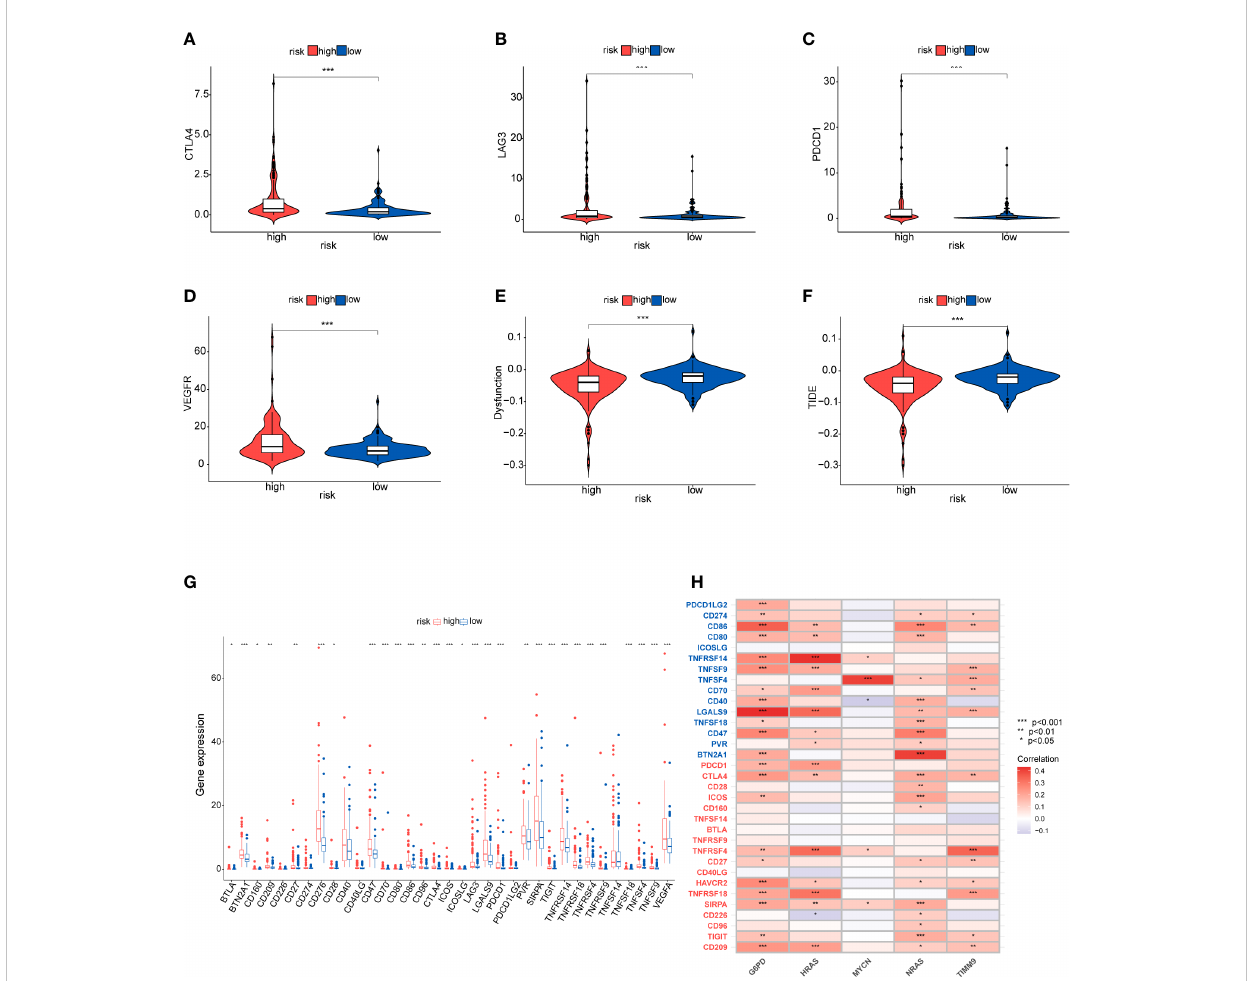
FIGURE 10 Immunotherapy response and immune checkpoint in the two risk groups (A-D) Comparison between the expression of four immune checkpoints in the high- and low-risk groups. (E, F) Comparison of dysfunction score and TIDE score. (G, H) The correlation between the fi ve-gene signature and immnue checkpoint genes. Tumor cell/APC/DC groups genes (blue), T cell group genes